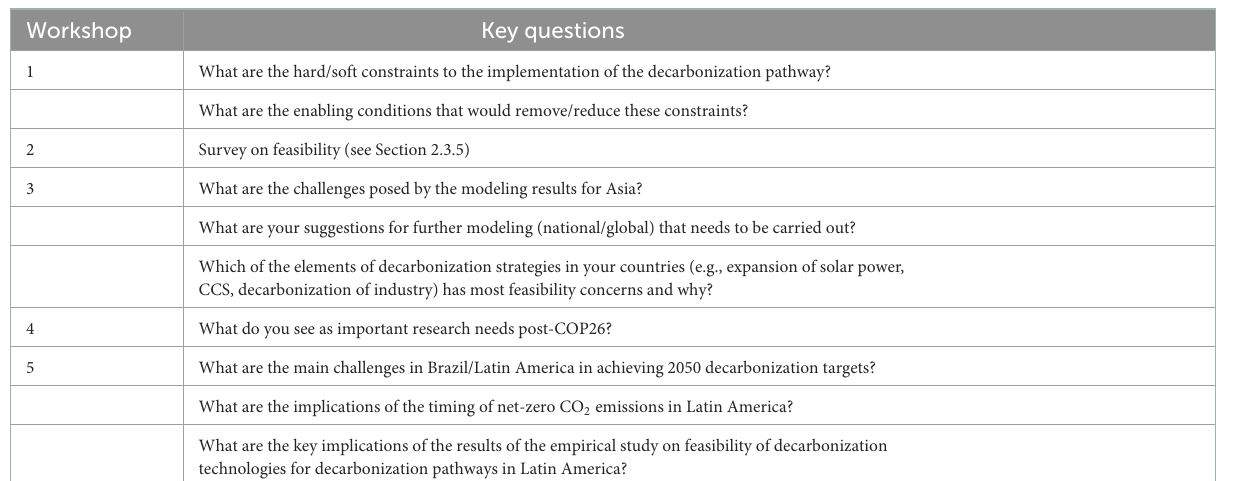
TABLE 3 Key questions to guide group